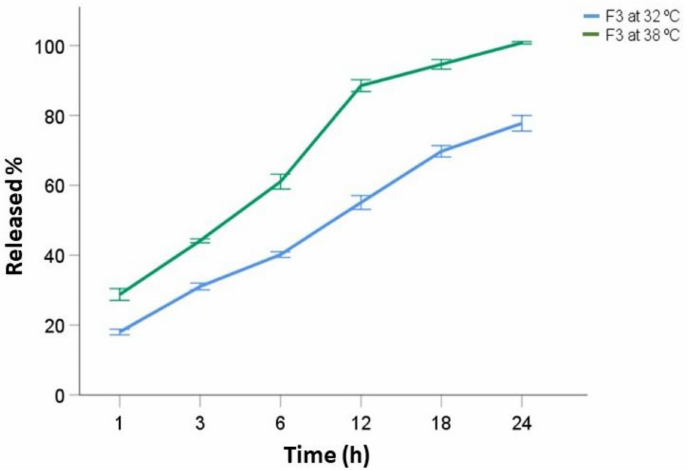
Figure 6. F3 average drug release comparison at 32 ◦ C (blue) and 38 ◦ C (green) (data are presented as mean of ± standard deviation, n =